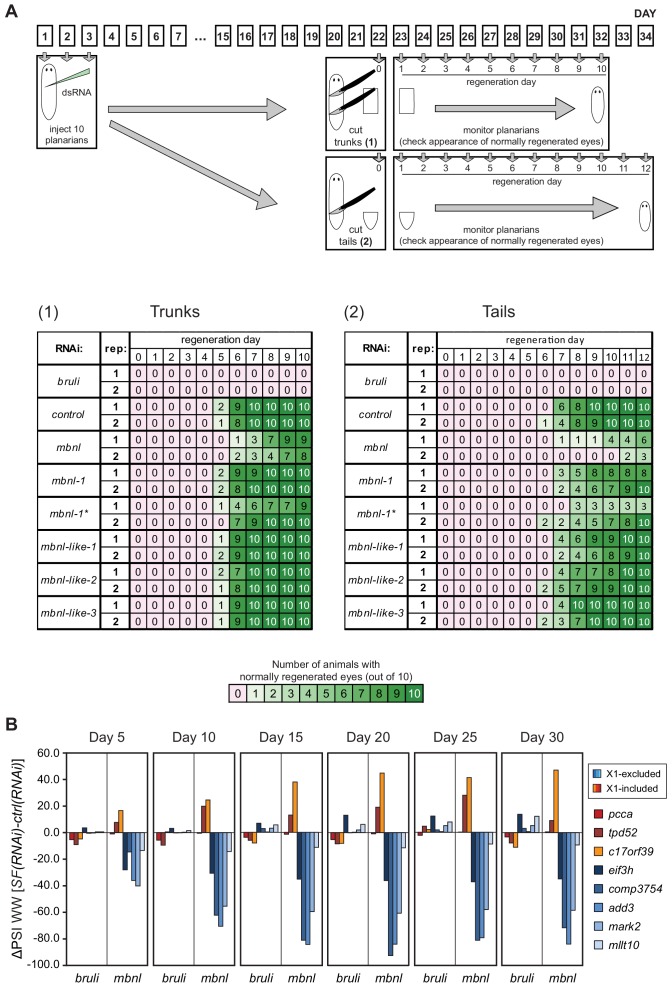
bruli and mbnl factors effects on regeneration and alternative splicing.(A) The effects of bruli and mbnl knockdown and mbnl-1 single knock down are reproducible and dependent on the level of cut. Top: Workflow of the experiment: 10 animals per experimental group and time point were injected with dsRNA coding for bruli, gfp as a control and a mix of dsRNAs against the four mbnl genes and cut 22 days after RNAi; trunk and tail pieces were monitored independently. Two independent dsRNAs coding for different regions of mbnl-1 were used (mbnl-1 and mbnl-1*). The experiment was replicated twice independently. Bottom: Results of the scoring for trunk and tail regeneration experiments; color key is indicated below. (B) The effects of bruli and mbnl knockdown on AS events are detectable 5 days after RNAi and are permanent for at least 30 days: quantifications for two X1-inc exons (red), one X1-inc retained intron (c17orf39, orange) and five X1-exc exons (blue) 5, 10, 15, 20, 25 and 30 days after RNAi treatment with dsRNA coding for bruli, gfp as a control and a mix of dsRNAs against the four mbnl genes.